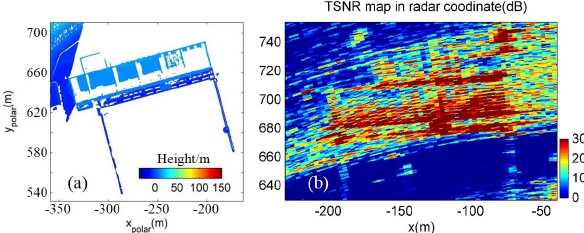
Figure 7. 3D coordinates on the edge of power plant and its corresponding GB-SAR image.